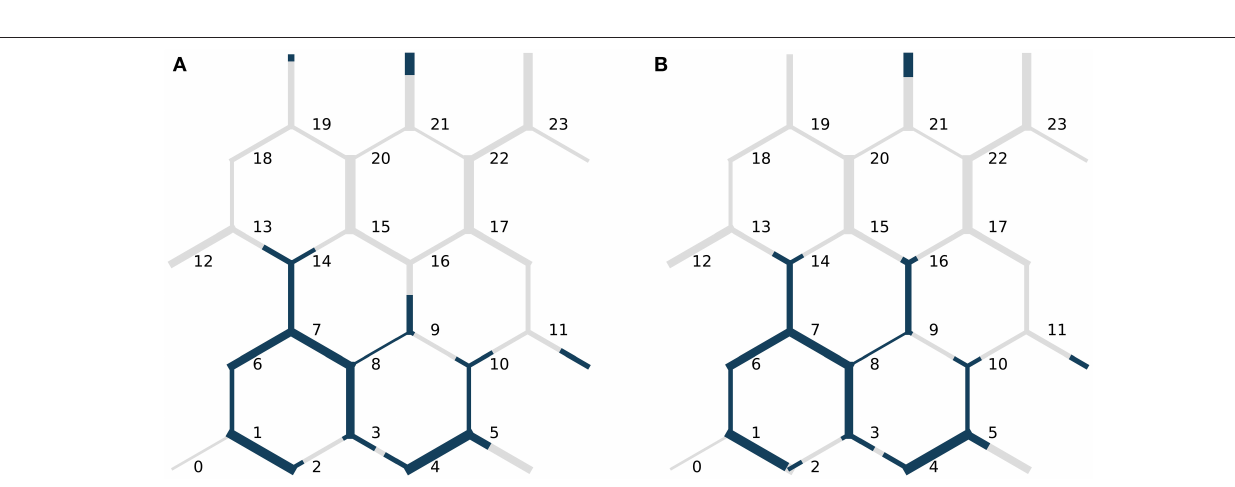
Figure 6C . For brevity, the results from the Haines jump